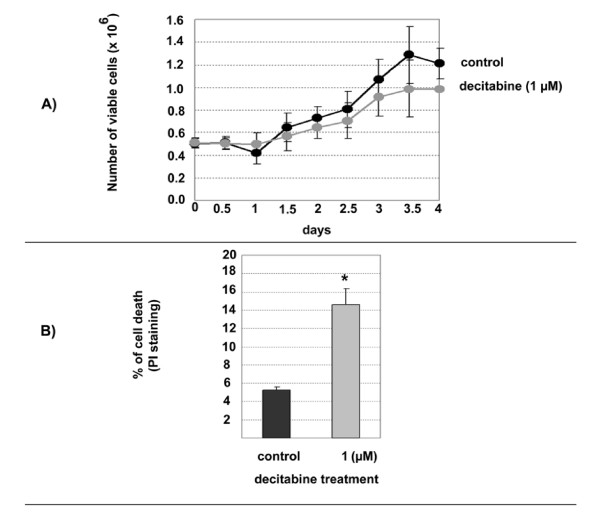
Viability and growth kinetics of U2OS in vitro. A), Growth curves of U2OS cells with growth medium alone (dark line), or growth medium with one dose of decitabine at a final concentration of 1 μM (light graph). The y-axis indicates cell number in millions and the x-axis indicates time points in days. The results are expressed as cell counts at each corresponding time point. Each data point is the Mean of cell counts from 2 experiments (5 passages apart) each consist of 2 independent cultures and the error bars indicate the standard deviation. The findings indicate a slight increase of U2OS cells' doubling time and a decrease of 18% (p = 0.045) in the viability of treated cells compared to untreated control B), Cell death in U2OS cells caused by decitabine treatment at 1 μM concentration (light column) compared to no-treatment (dark column). The results are expressed as percentage of cell death (fraction of cells with positive PI stain). The y-axis indicates the percentage of cells with PI staining (dead cells). Each column is the Mean of 3 experiments with error bars indicating standard deviation. The asterisk indicates significant increase in cell death (p < 0.05) as a result of decitabine treatment.